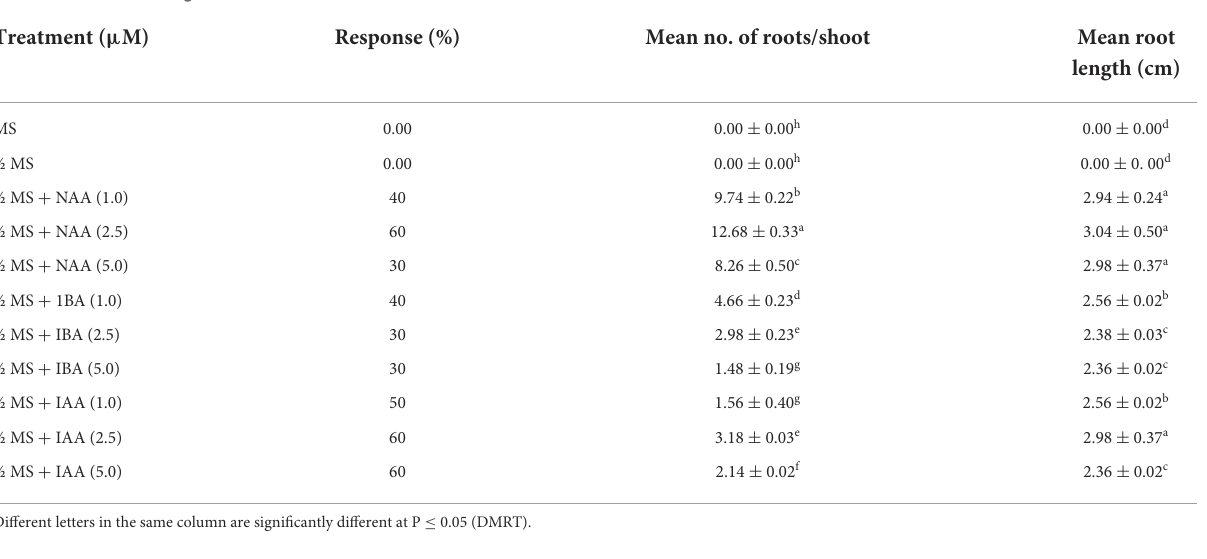
TABLE 4 In vitro rooting in microshoots (means ± SE) (after 6 weeks of transfer).